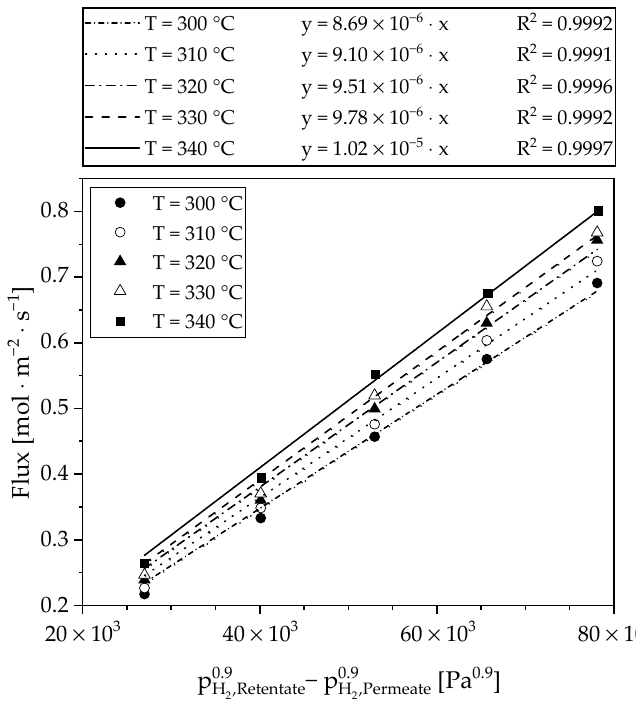
Figure 6. Sieverts plot of the investigated 5 µm thick PdAg membrane. The fitting of the measured data resulted in a Sieverts exponent of n = 0.9.